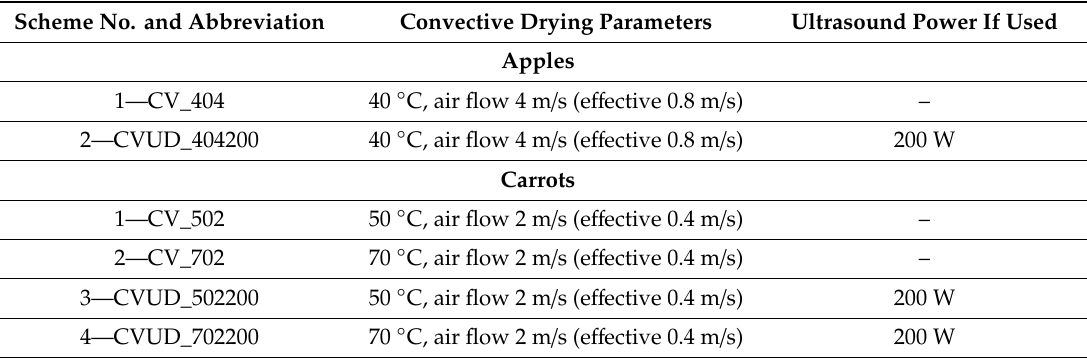
Table 1. Drying schemes and